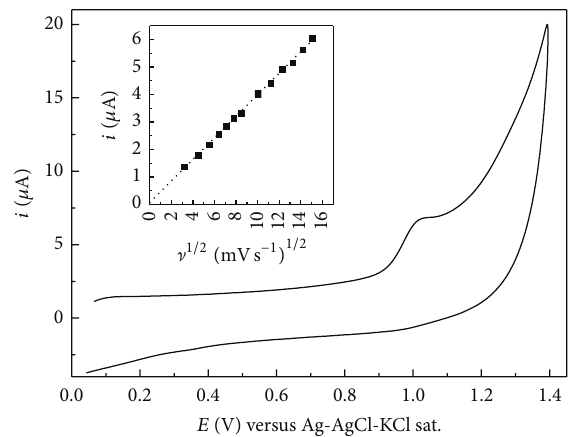
Figure 1: Cyclic voltammograms of 5.0 × 10 −5 M FXN on GCE in 0.2 M phosphate buffer solution (pH 4.7). Scan rate 50mVs −1 . Inset: plot of anodic peak current ( 𝑖 𝑝 ) for the oxidation of FXN against the square root of potential sweep rate ( ] 1/2